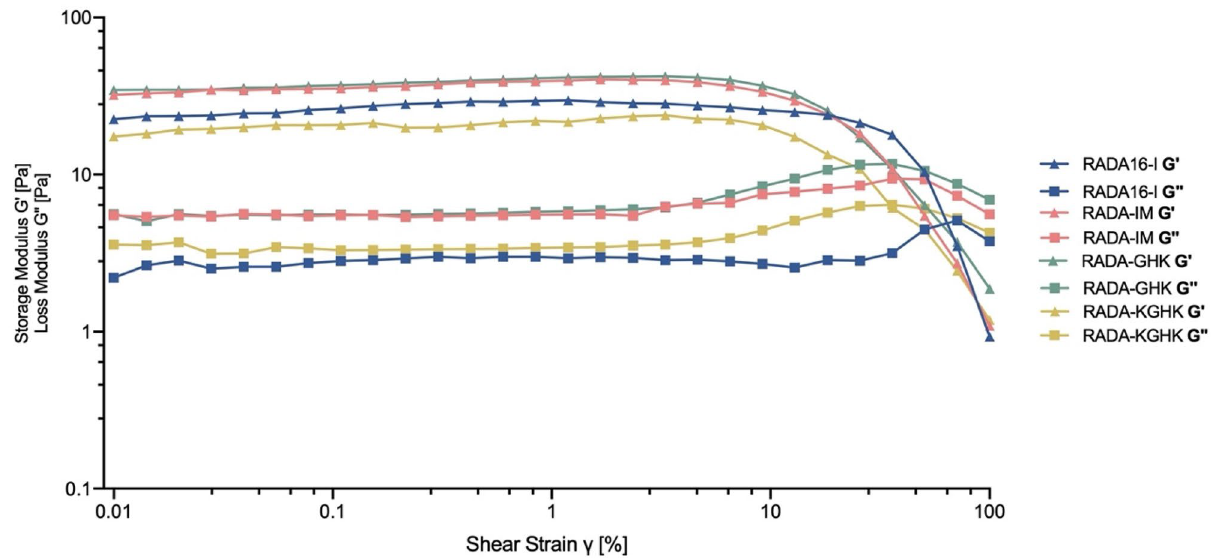
Figure 10. G’ and G” of RADA16-I hybrids as a function of shear strain at ω = 6.28 rad/s and 37 °C.